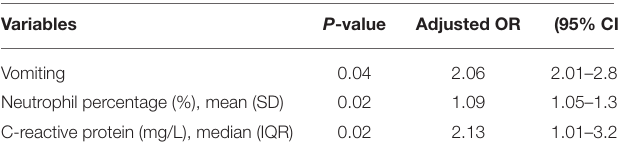
TABLE 3 | Multivariate regression analysis of risk factors for HD bowel perforation in